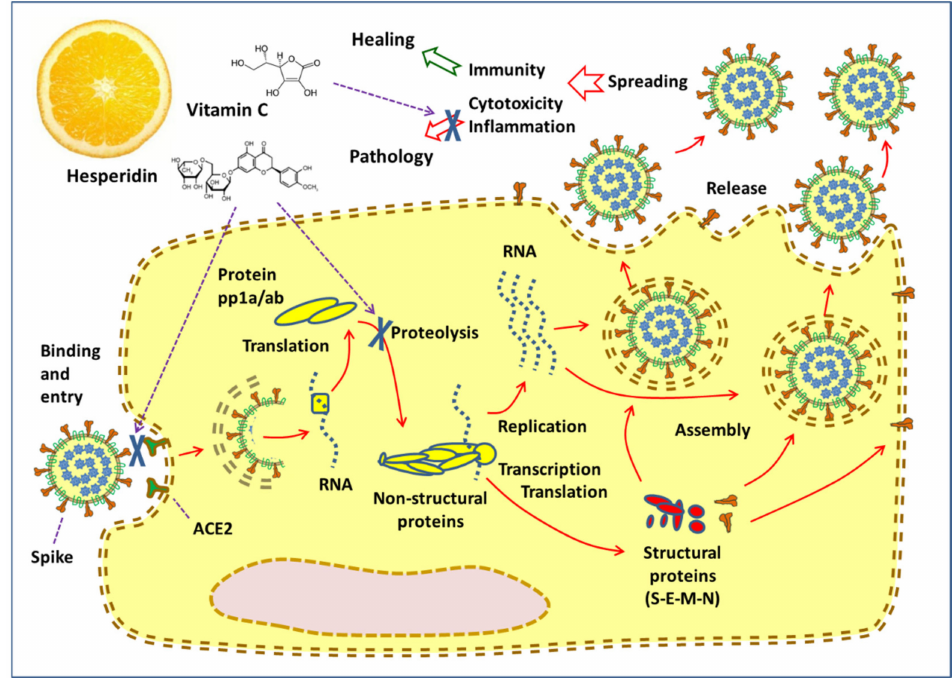
Figure 1. Cellular cycle of the Severe acute respiratory syndrome coronavirus 2 (SARS-CoV-2) virus and the places of the inhibition of virus-induced cellular and systemic pathology by hesperidin and vitamin C (indicated with